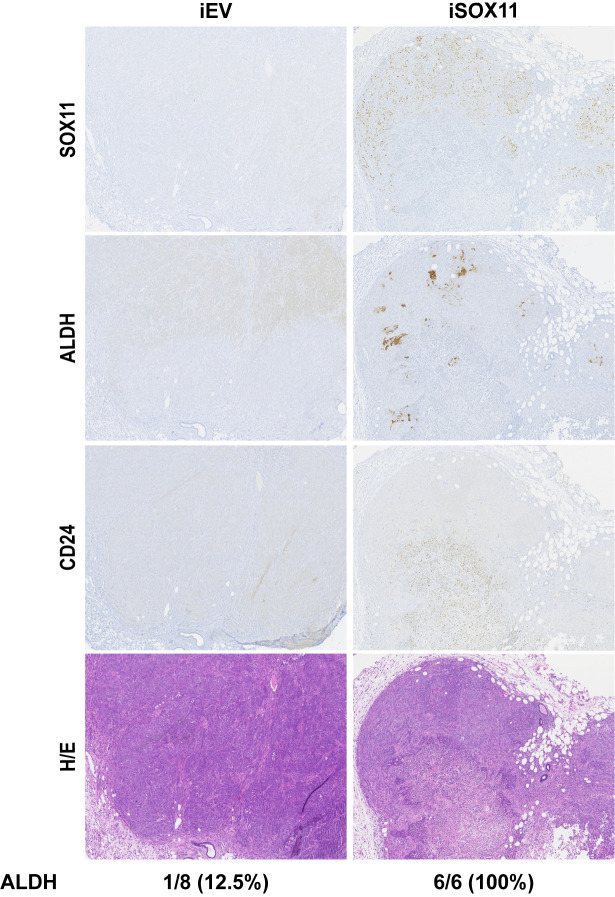
Panel shows photomicrographs of primary fat pad tumours following immunohistochemical detection of SOX11, ALDH1A1, CD24, and H and E staining.Data shown are from mice xenografted with iEV and iSOX11 cells and fed DOX chow. DOX: Doxycycline, H and E: Haematoxylin/Eosin.